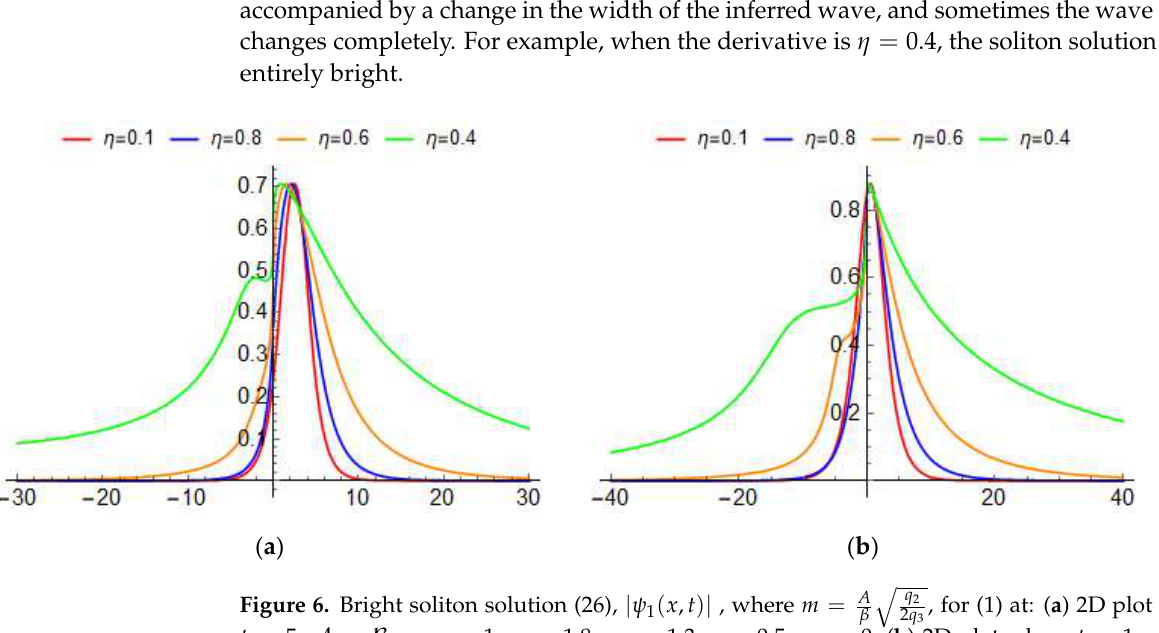
Figure 5. Bright soliton solution (26), |𝜓 (cid:2869) (𝑥,𝑡)| , where 𝑚 = 𝑞 (cid:2871) = 𝛾 = 1,𝑎 (cid:2872) = 0 : ( a ) integer derivative order 𝜂 = 1 ; ( b ) fractional derivative order 𝜂 = 0.68 . q 3 = γ = 1, a 4 = 0: ( a ) integer derivative order η = 1; ( b ) fractional derivative order η = 0.68.